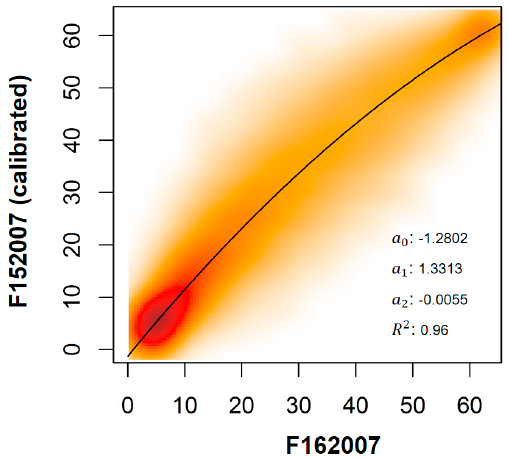
Figure 4. Relationship (and coefficients) of NTL DNs between calibrated F152007 and F162007.